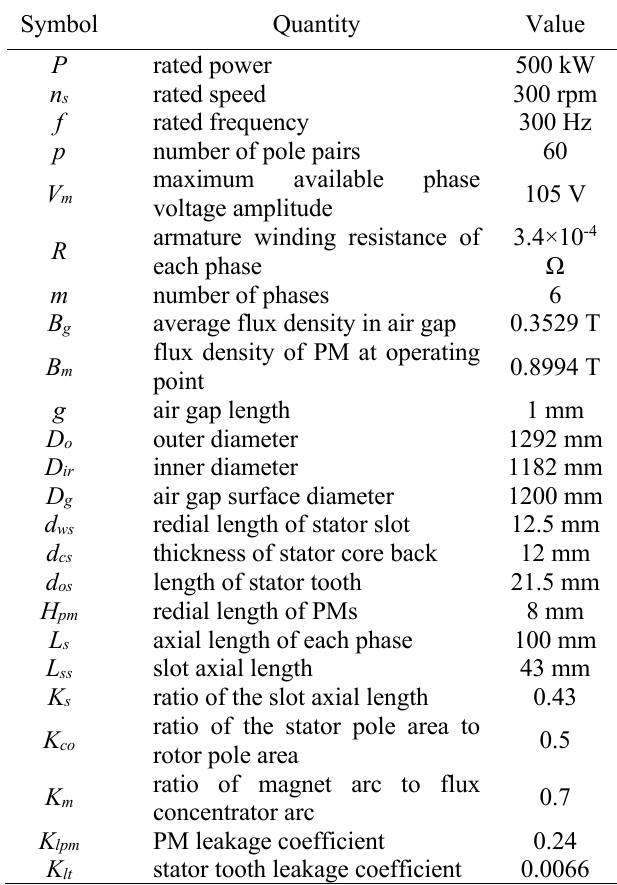
Table 3: Ratings and parameters of the case study